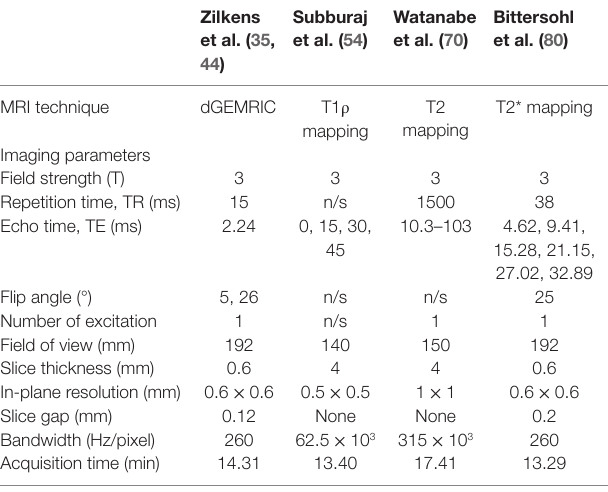
TABLe 1 | Selected imaging parameters of previously reported studies of dGeMRiC, T1 ρ , T2, and T2* assessment of hip joint cartilage.